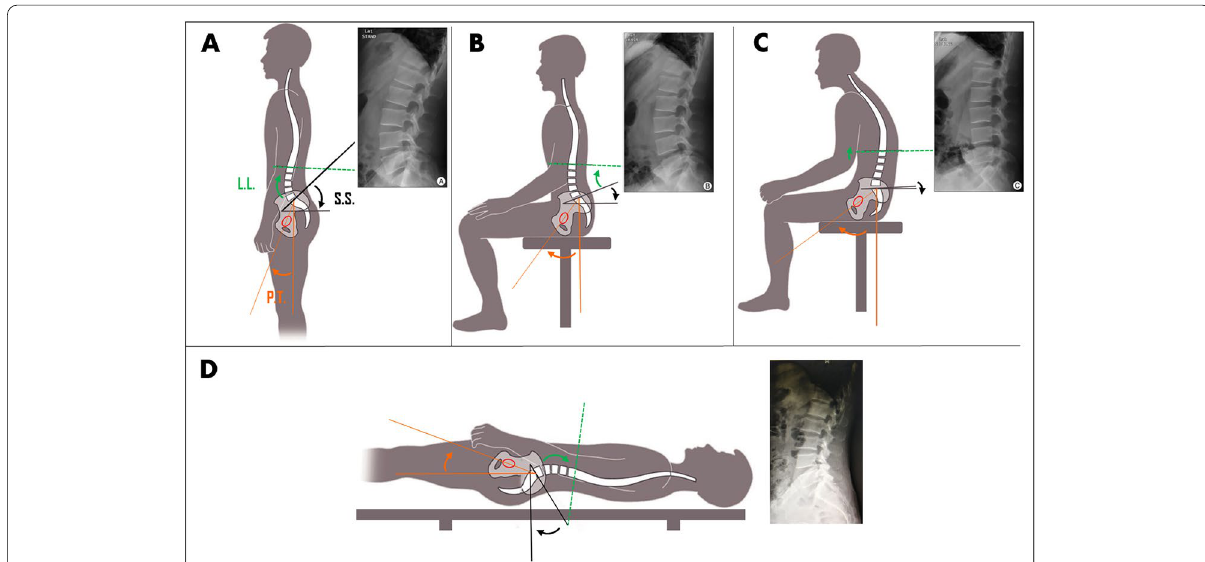
Fig. 2 The hip-spine relation at different positions of standing, upright sitting, declined sitting, and supine position. A Typical parameters used for evaluating hip-spine coordination in standing, LL 46°, SS 43°, PT 20°. B Typical parameters used for evaluating hip-spine coordination = = = in upright sitting, LL 24°, SS 21°, PT 35°. C Typical parameters used for evaluating hip-spine coordination in declined sitting, which imitates = = = lateral decubitus position in traditional posterolateral approach THA, LL 4°, SS 2°, PT 54°. D Typical parameters used for evaluating hip-spine = = = coordination in supine position, which imitates supine DAA, LL